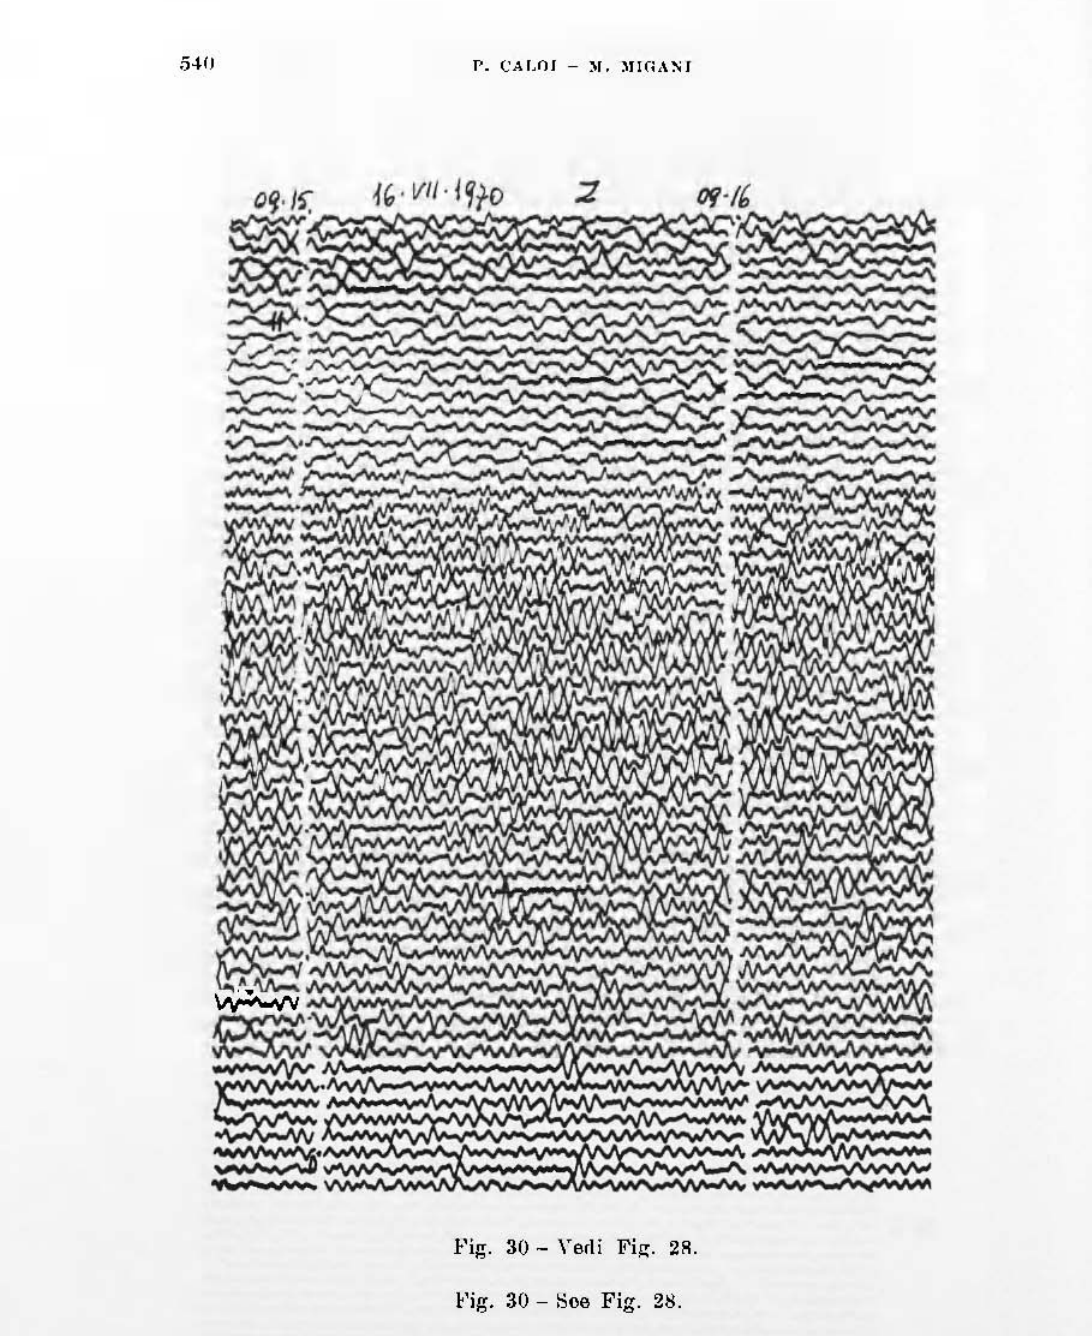
Fig. 30 - Yerli Fig-. 21'1. ~'ig. 30 - ~oo Fig.